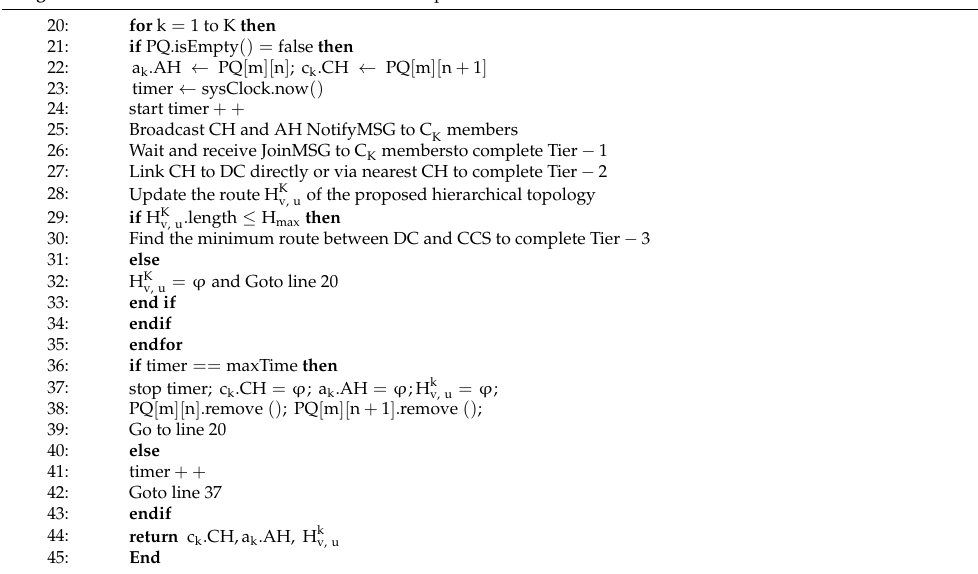
Algorithm 2 for dual-head selection and rotation for optimal route